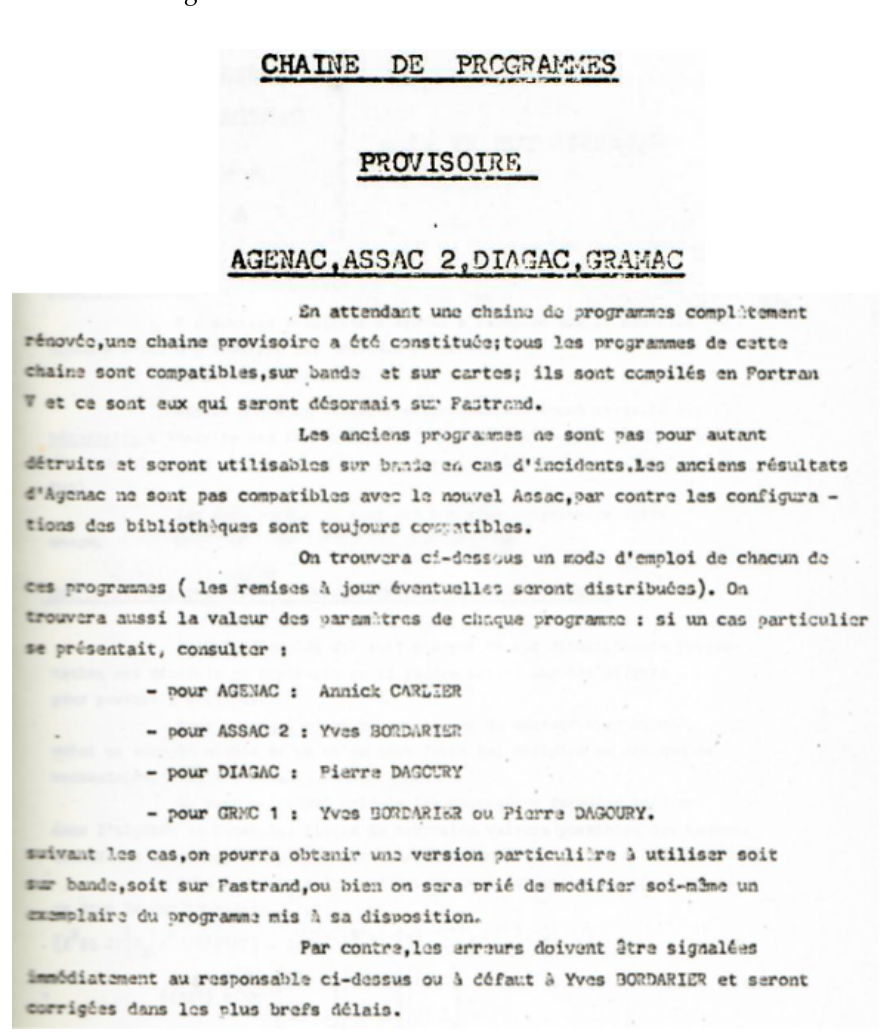
Figure 4. The first page of the manual for the French suite of atomic codes.